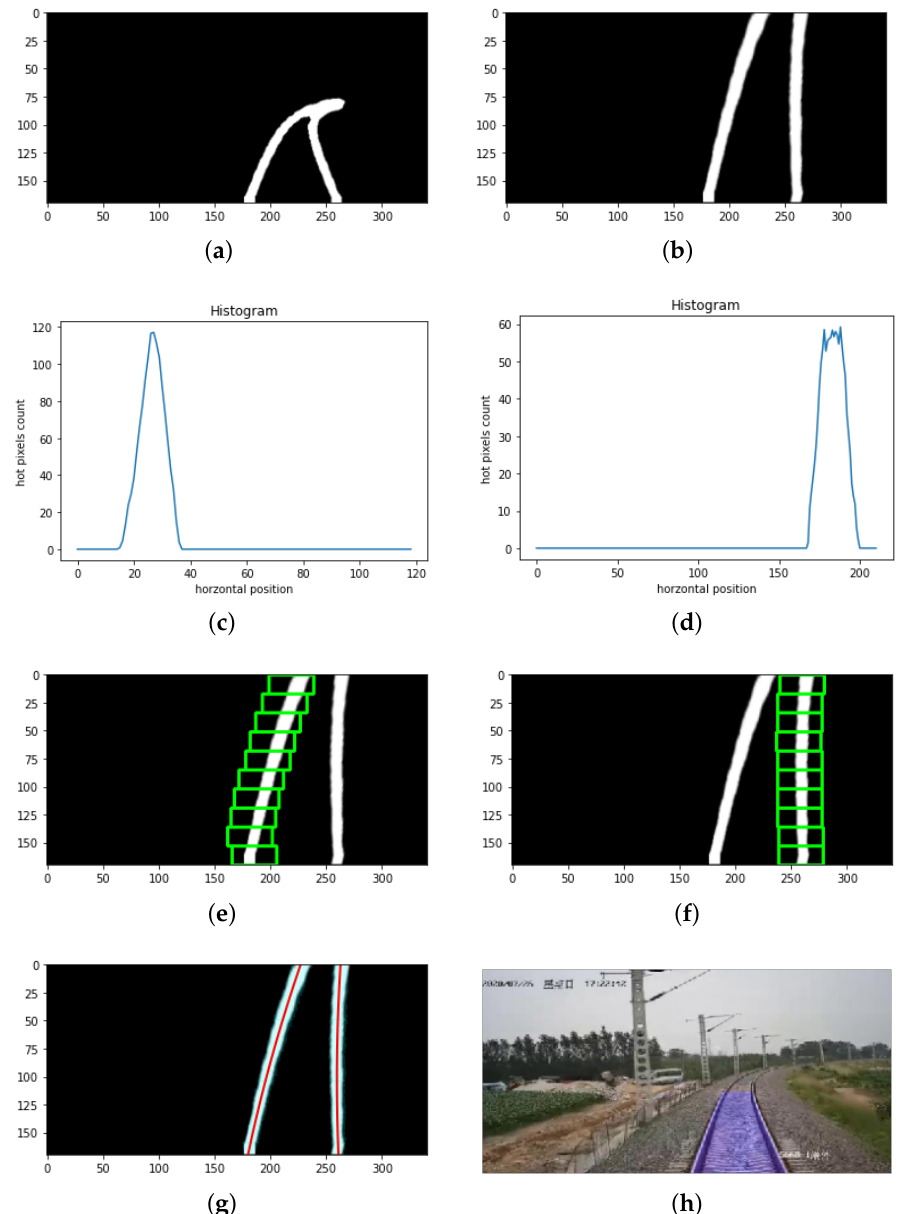
Figure 7. Experiment process of the algorithm. ( a ) Binary segmentation diagram. ( b ) Inverse perspective transformation diagram. ( c ) Histogram detection of left rail diagram. ( d ) Histogram detection of right rail diagram. ( e ) Result of sliding window detecting left rail. ( f ) Result of sliding window detecting right rail. ( g ) Schematic of characteristic point curve fitting. ( h ) The final rail line